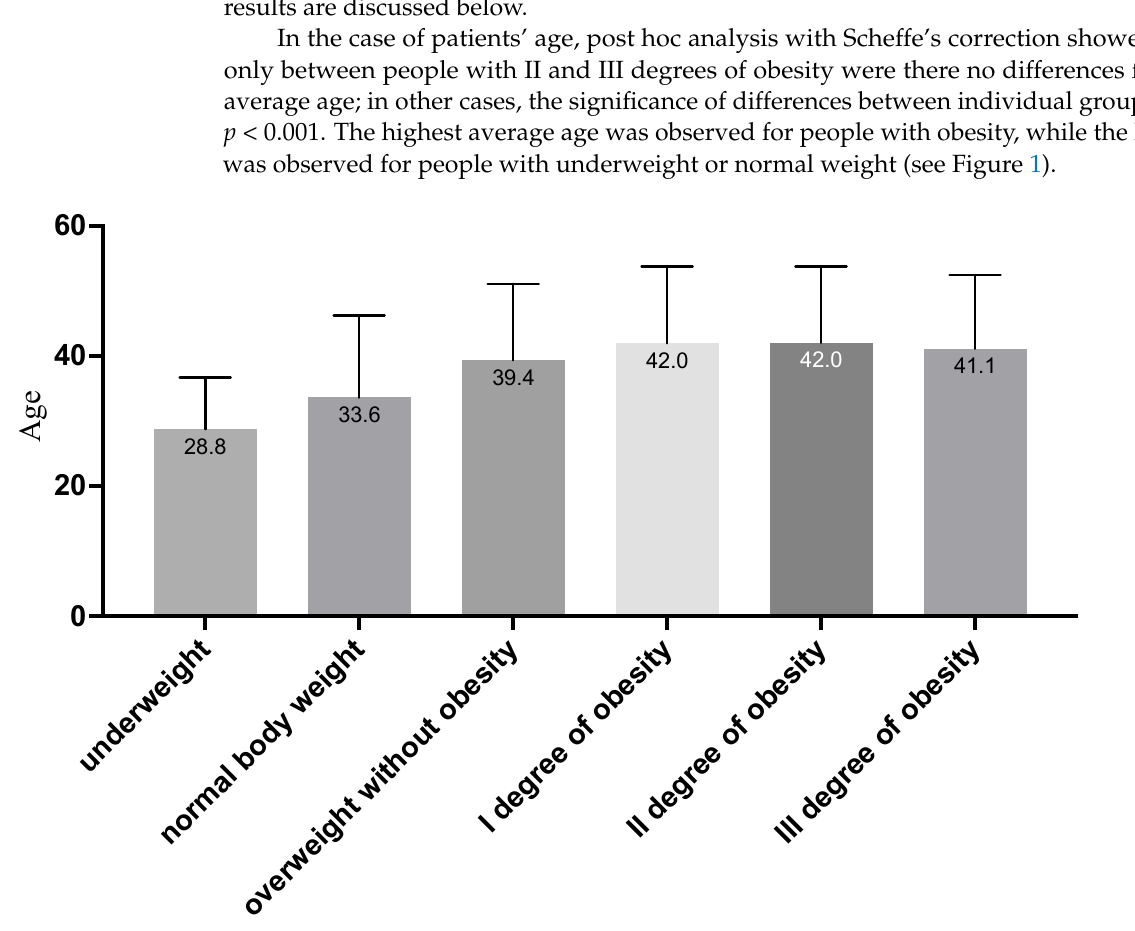
Figure 1. Average age depending on the BMI category (in the figure, all groups are statistically significantly different, at least at the p < 0.001 level; due to the number of groups compared, results for differences are not shown in the figure).